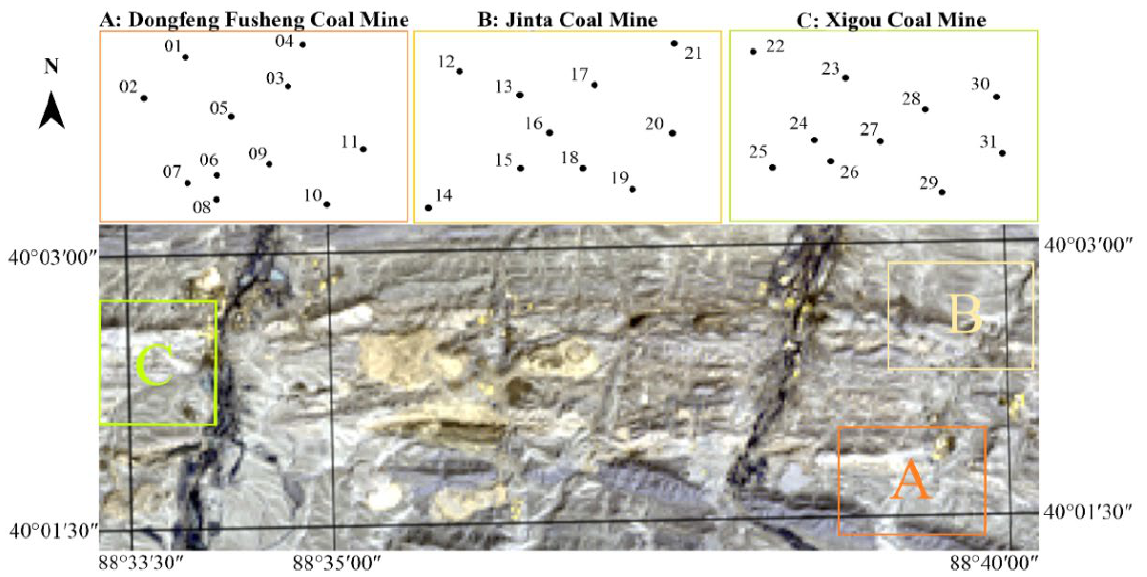
Figure 1. Schematic diagram of the sampling points in the study area.